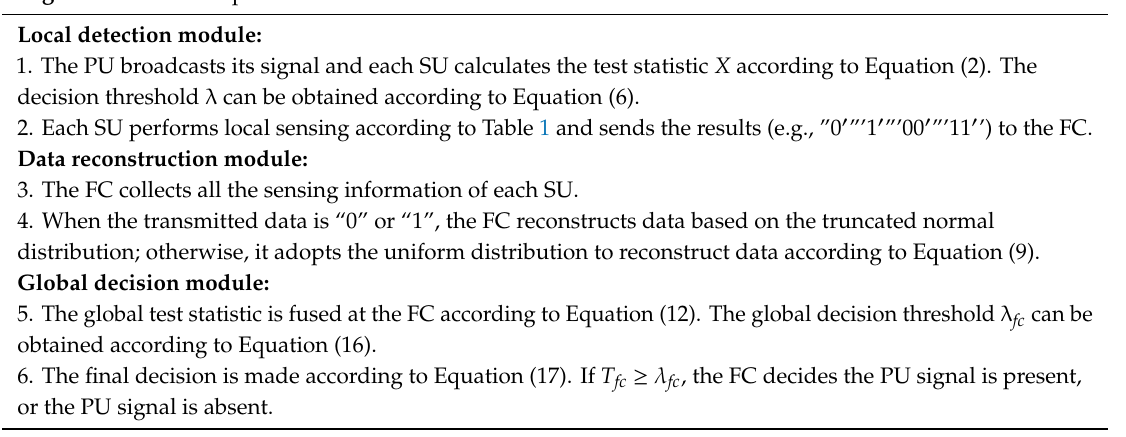
Algorithm 1. The Proposed Semi-Soft Decision